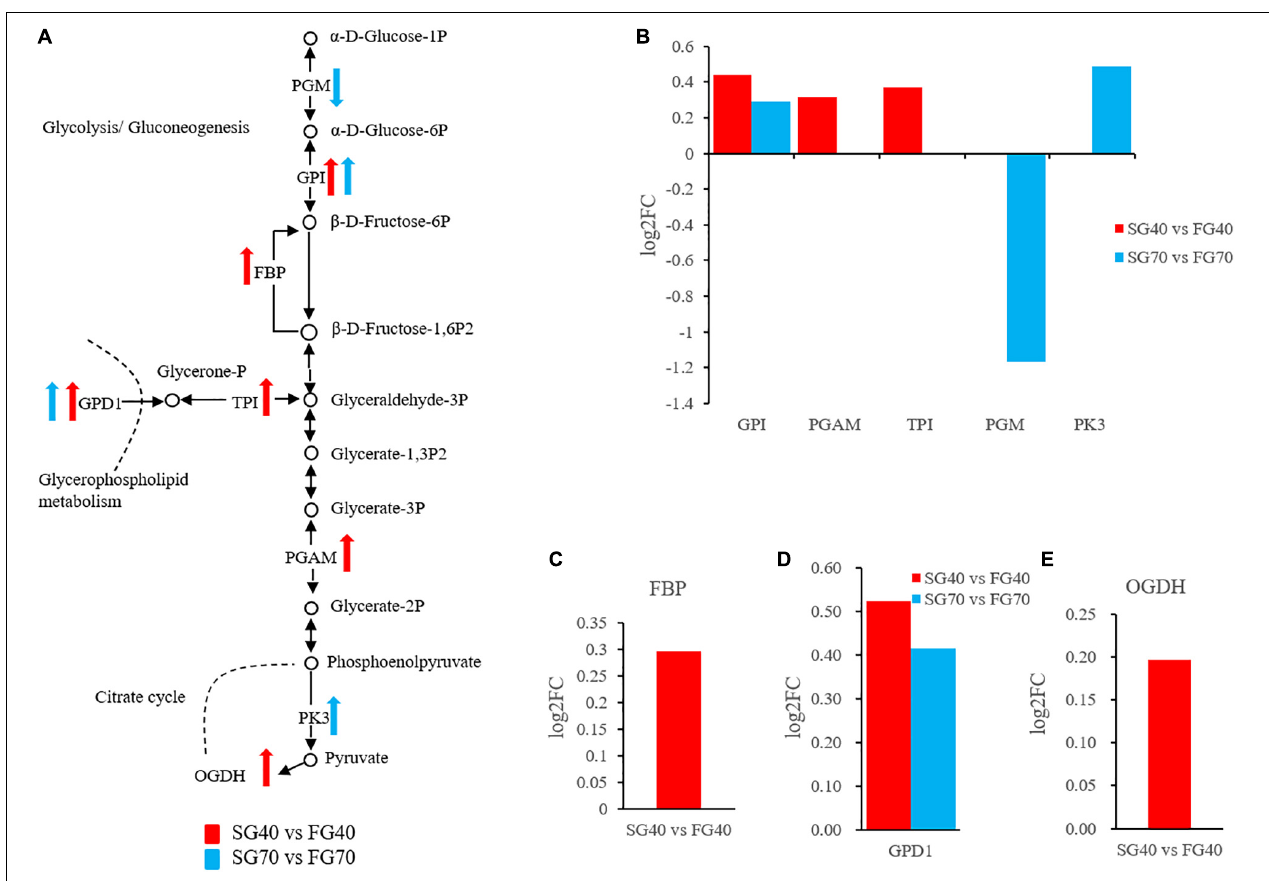
FIGURE 6 | The glycolytic pathway regulates the growth of M. japonicus . (A) Glycolytic network regulation diagram; (B) DEPs expression in glycolysis; (C) DEP expression in gluconeogenesis; (D) DEP expression in glycerophospholipid metabolism; and (E) DEP expression in citrate